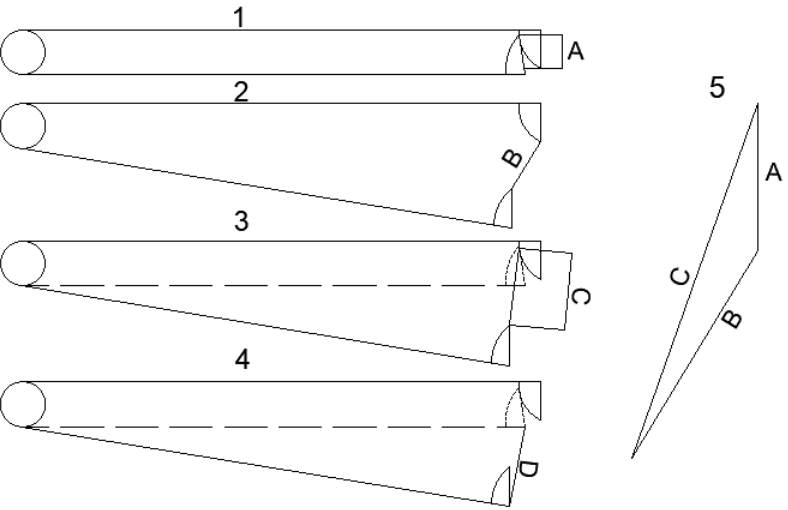
Figure 9. ( 1 ) Overbite between the upper and lower incisors, A. ( 2 ) Distance between the incisal edges, B. ( 3 ) Distance between the starting and end points of the incisal edge of the lower incisor, C. ( 4 ) Distance obtained from the record of the starting and end points of the interincisal sensor, D. ( 5 ) Diagram that shows the differences between the distance desired to be estimated, C, compared to B and A. As can be seen, C is different from both B and from the distance obtained by adding A and